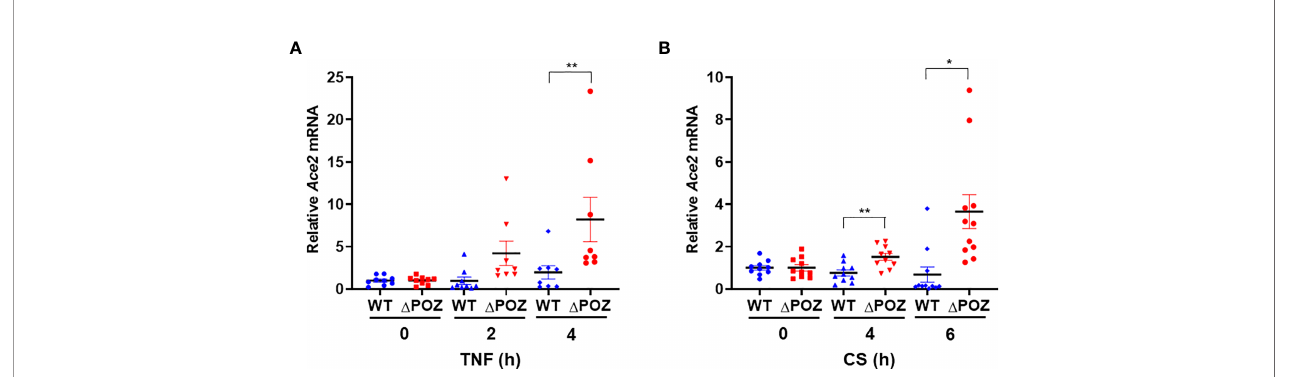
FIGURE 7 | Loss of function of MIZ1 augments Ace2 expression in response to TNF or CS. (A, B) Ace2 mRNA levels in TNF- (A) or CS-treated (B) MLE-12/Miz1 (WT) and MLE-12/Miz1( d POZ) cells as indicated. Data are presented as means ± sem (fold changes normalized to corresponding non-treated controls) from three independent experiments. TNF, 5 ng/ml. CS, 100 µg/ml. * p < 0.05 and ** p